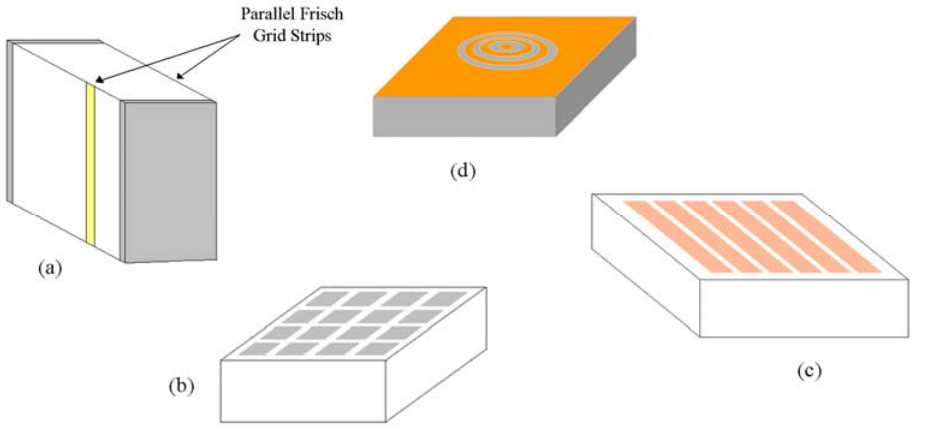
Figure 17. Single charge collection electrode configurations widely used in CdTe and CdZnTe detectors: (a) parallel strip Frisch grid design, (b) pixels, (c) strips and (d) multiple